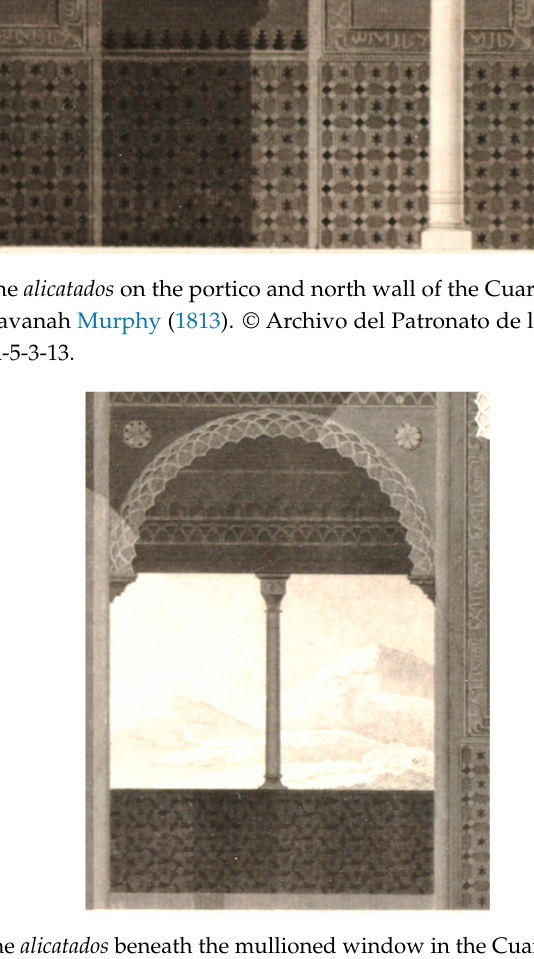
Figure 16. Detail of the alicatados beneath the mullioned window in the Cuarto Dorado (Plate XXVIII). Drawing by James Cavanah Murphy (1813). © Archivo del Patronato de la Alhambra y Generalife, Fondo Romanones,